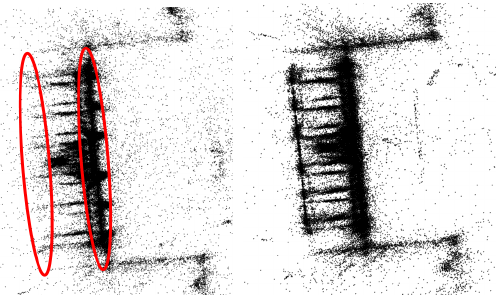
Figure 1. Reconstructions from uncontrolled images are some- times compromised by duplicate structure and/or missing parts (left). Using the GNSS tags available for a small proportion of the images can mitigate the problem